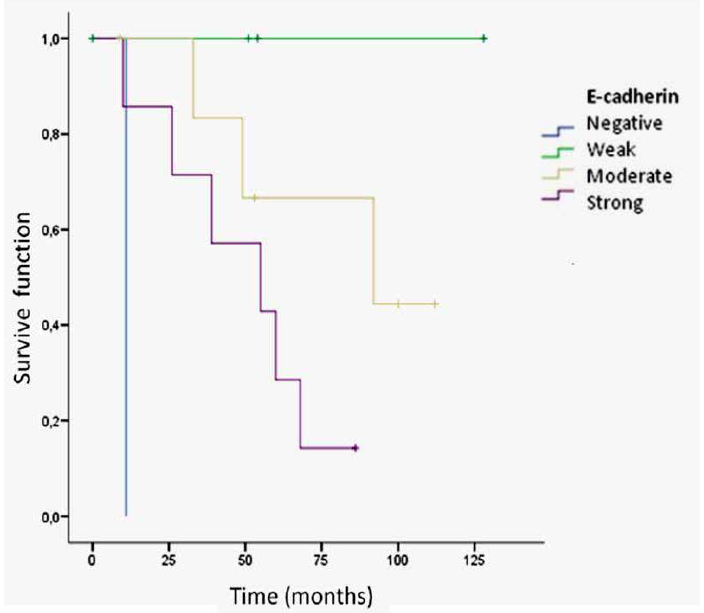
Figure 3 - Kaplan-Meier curve for recurrence-free survival according to E-cadherin expression